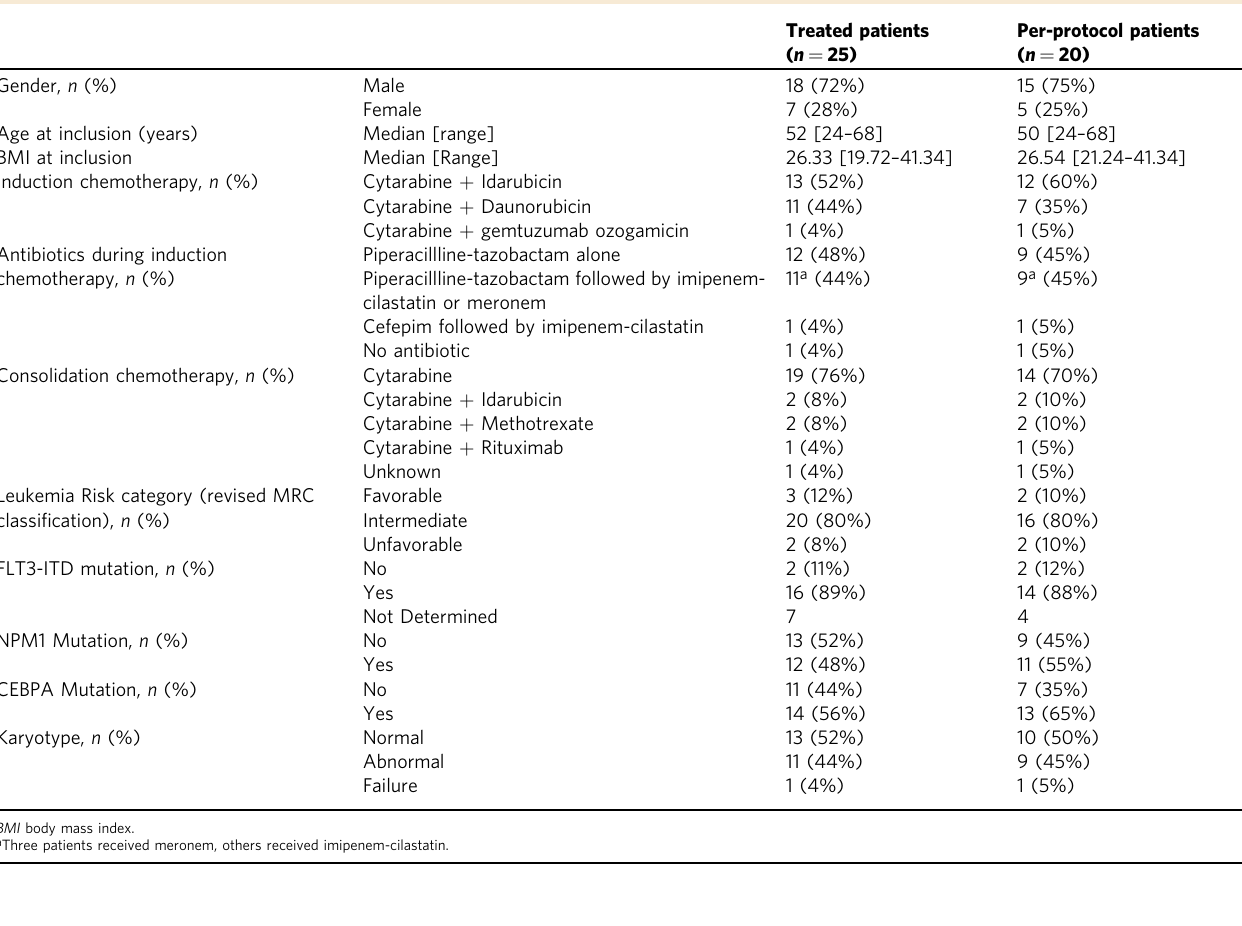
Table 1 Baseline demographics and clinical characteristics of treated and per-protocol patients.